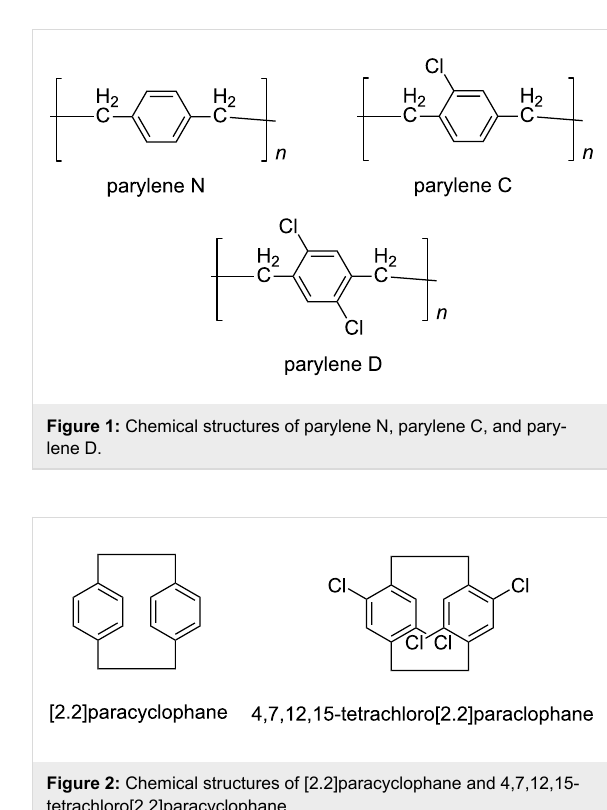
Figure 2: Chemical structures of [2.2]paracyclophane and 4,7,12,15-